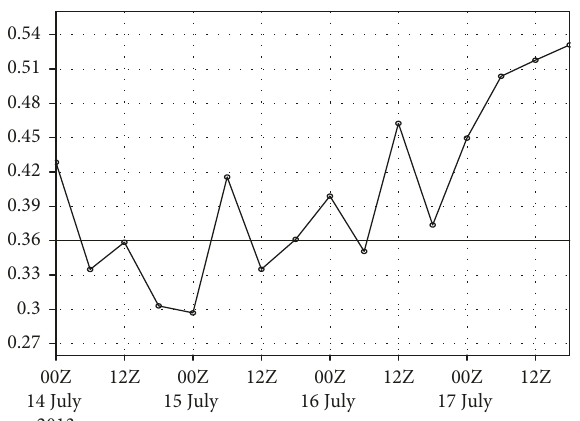
Figure 8: Time series (6h interval) of correlations between WPSH (the averaged 500hPa GPH over the area in dashed blue box shown in Figure 6) in forecast for next 0–90hours after the initial time and TPMVI. The horizontal line with R � 0.36 shows the correlation reaching the 95% confidence level.